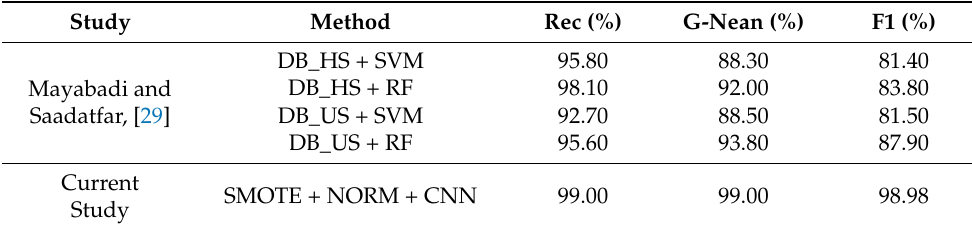
Table 13. The comparison of performance metrics on the same dataset. Study Method Rec (%) G-Nean (%) F1 (%) DB_HS + Mayabadi and Saadatfar, [29]